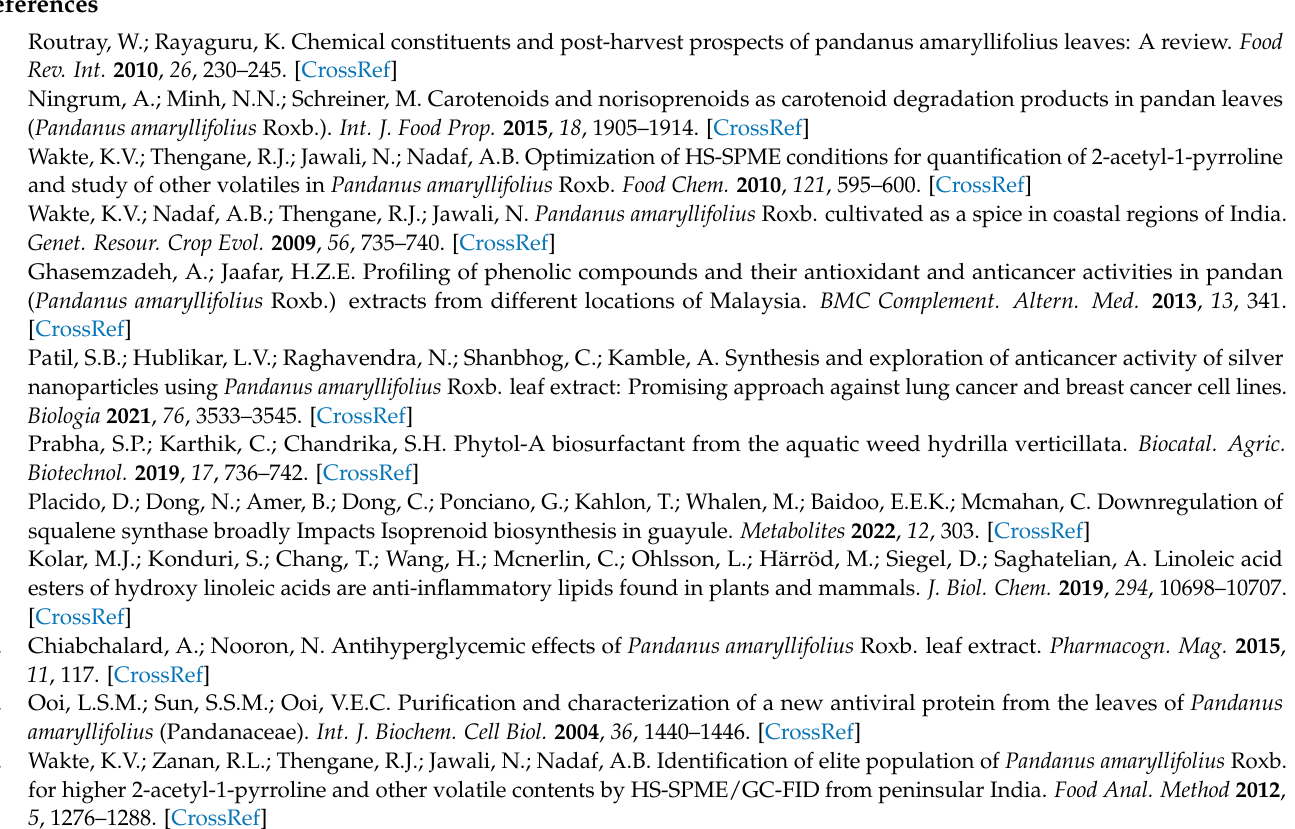
Figure A1. Effects of monoculture and intercropping patterns on the stomatal conductance ( a ), photosynthesis ( b ), transpiration ( c ), and water use efficiency ( d ) of Hevea brasiliensis . n = 10. M: Hevea brasiliensis monoculture, I: Pandanus amaryllifolius and Hevea brasiliensis intercropping. Different letters represent significant differences at p < 0.05.